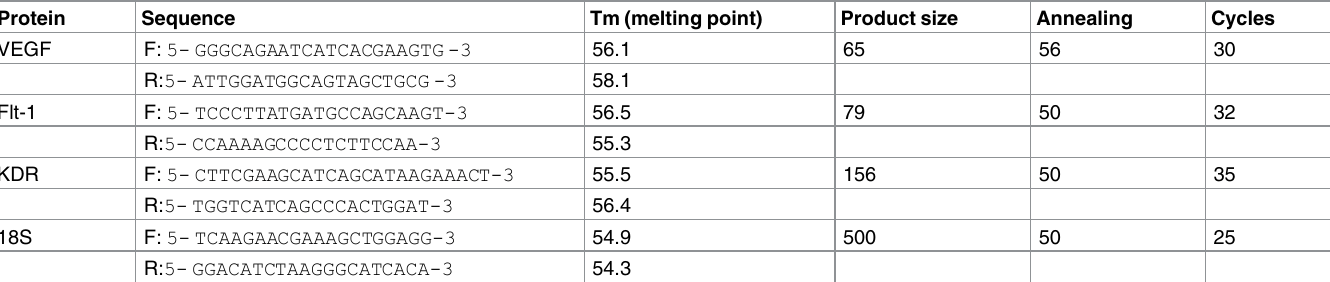
Table 1. Primers used for